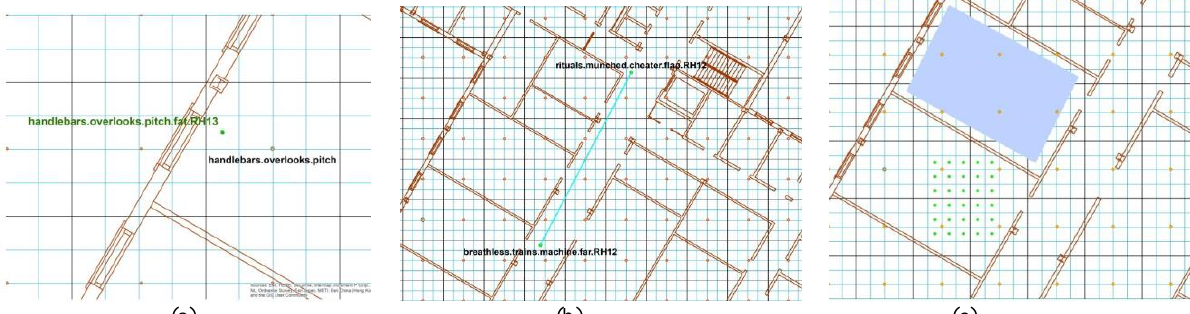
Figure 14. Visualization of (a) forward geocoding of a five-word code, (b) line encoding of Head Hall hallway, (c) polygon encoding of room E4 and centre points encoding of defined area in room